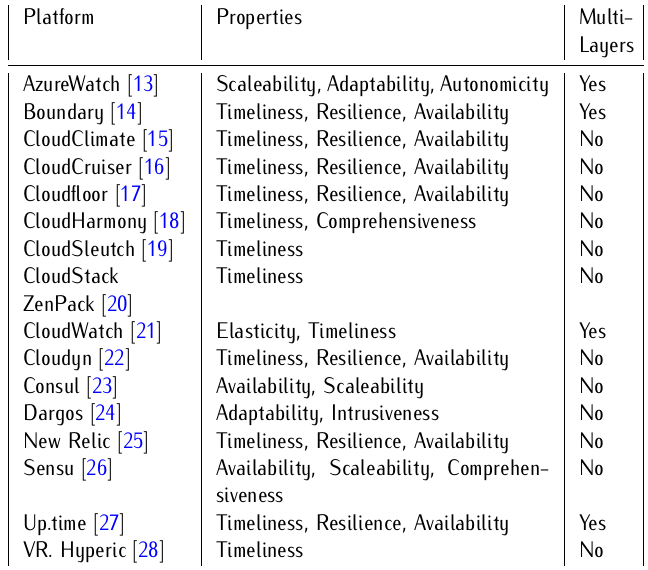
Table 1. Platforms